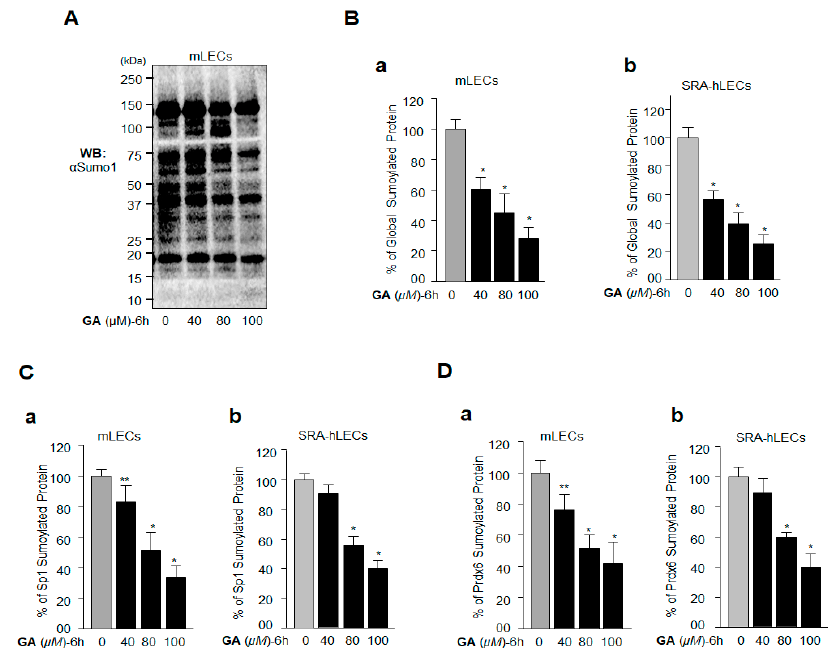
Figure 3. GA treatment inhibited protein Sumoylation in vivo in lens epithelial cells (LECs). ( A , B ) GA treatment led to a decrease of total Sumoylated proteins in mLECs and SRA-hLECs. ( A ) Total protein was isolated from mLECs, and treated with different concentrations of GA for 6 h as shown. Samples containing equal amounts of protein content were immunoblotted with the anti-Sumo1 antibody. The protein band below 20 kDa reflected equal loading of protein samples. ( B ) mLECs (a) and SRA-hLECs (b) were treated with different concentrations of GA as shown; 6 h later total cell extract was prepared. Equal amounts of protein were used for the Sumo1 ELISA assay to measure the total protein Sumoylation. The data represent the mean ± SD from three independent experiments. * p < 0.001. ( C ) (a) (mLECs) and (b) (SRA-hLECs) ( D ) (a) (mLECs) and (b) (SRA-hLECs)) GA treatment also inhibited Sumoylation of Sp1 and Prdx6. mLECs and SRA-hLECs were treated with GA as indicated. Lysate was prepared and used 6 h later, for the Sumo1 ELISA assay to measure the levels of protein Sumoylation. Anti-Sp1 and anti-Prdx6 antibodies were used to measure Sumoylation specific to Sp1 ( C ) and Prdx6 ( D ), respectively. The data represent the mean ± SD from three independent experiments. ** p < 0.05; * p < 0.001.